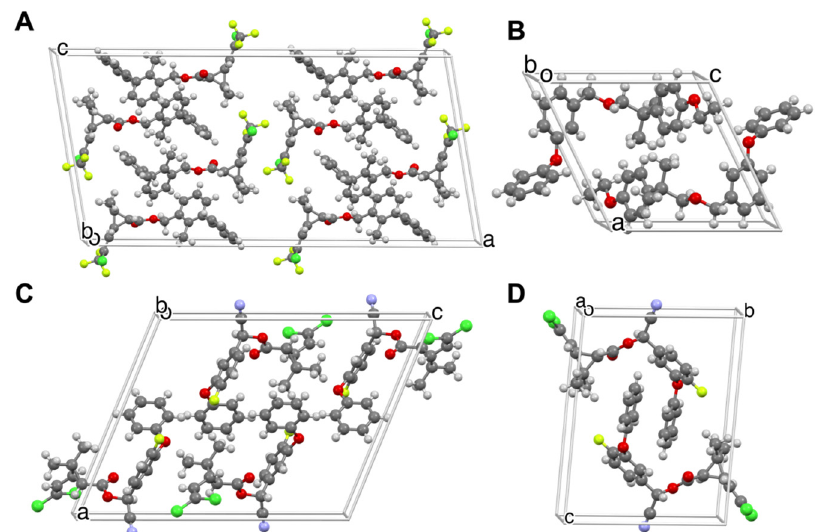
Figure 3. Crystal structures of ( A ) bifenthrin (BF), ( B ) etofenprox (ET), ( C ) rac- A β -cyfluthrin ( β -CF), and ( D ) rac- B β -cyfluthrin ( β -CF).